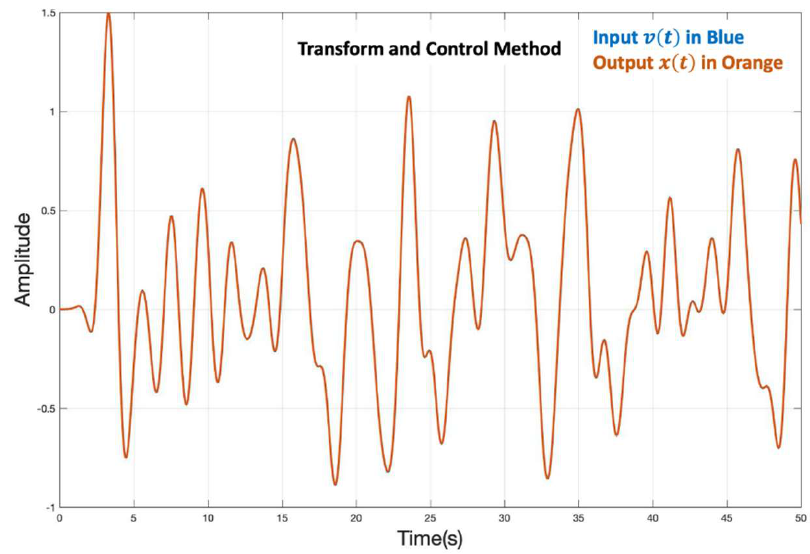
Figure 24. Response to Randomized Input (New Method).